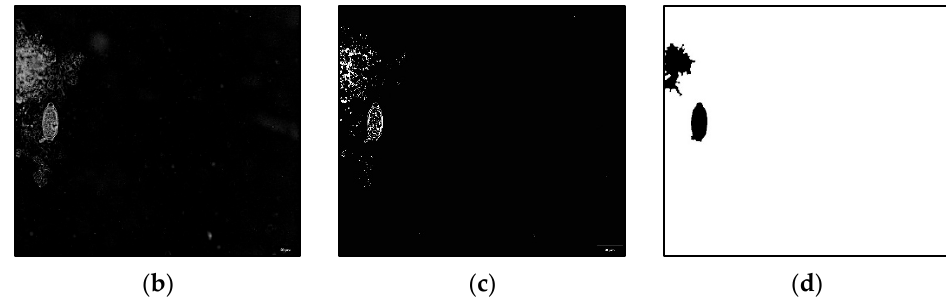
Figure 2. The results of machine learning segmentation technique on TTO image: ( a ) MGCS on TTO image; ( b ) CMYK_K color model on enhanced TTO image; ( c ) FCM segmentation on TTO image; ( d ) Post-processing on TTO image. Scale bar = 50 µ